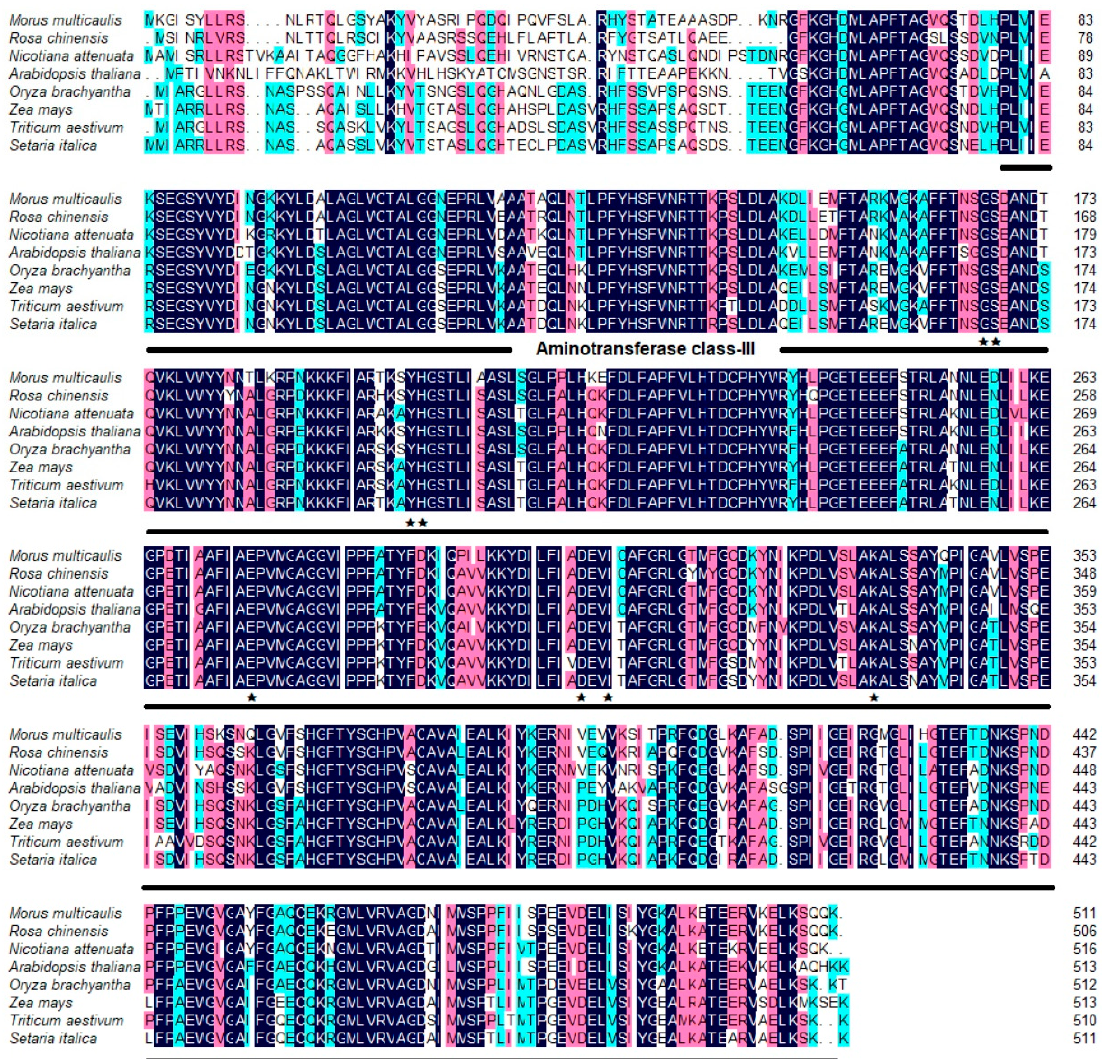
Figure 2. Alignment of the deduced amino acid sequences of MuGABA-T protein with GABA- transaminase (GABA-T) family members from other plants. The identical amino acid residues are shown in black and the similar amino acids are red shaded. Asterisks indicate the conservative pyri- doxal 5 (cid:48) -phosphate binding sites. The heavy point indicates the conserved domain aminotransferase class-III. The aligned sequences include those proteins from Morus multicaulis (OM289663), Rosa chi- nensis (XP_024182390.1), Nicotiana attenuate (XP_019230459.1), Arabidopsis thaliana (NP_001189947.1), Oryza brachyantha (XP_006652817.1), Zea mays (ACF87978.1), Triticum aestivum (XP_044325747.1) and Setaria italica